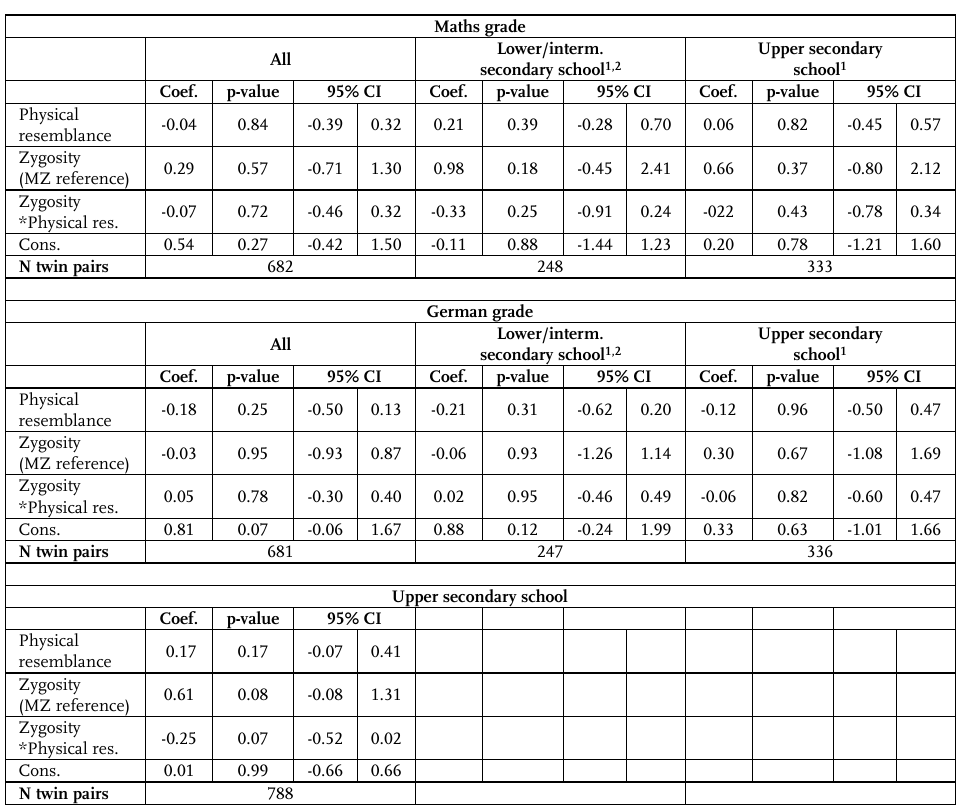
Table 6 : Regression output for physical differences explaining trait differences (twin-pair